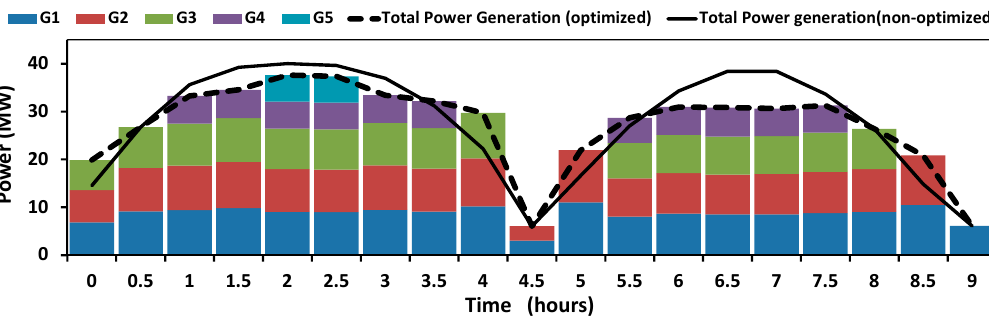
Figure 7. Optimal generator set power production, non-optimized ship electric load (PSO-EEOI unlimited).